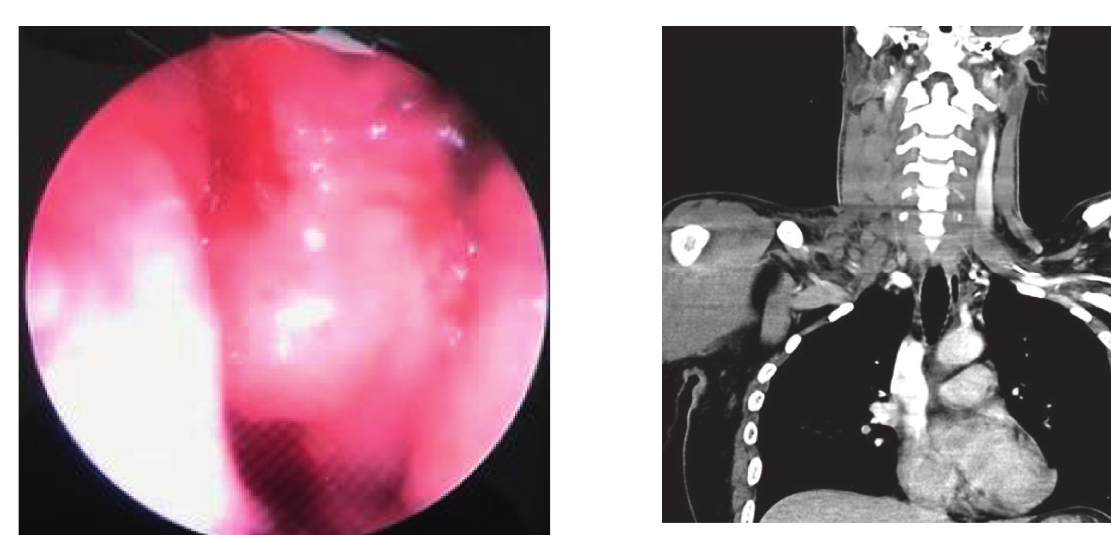
Figure 2: Coronal CT imaging of the neck showing right-sided cervical lymphadenopathy.